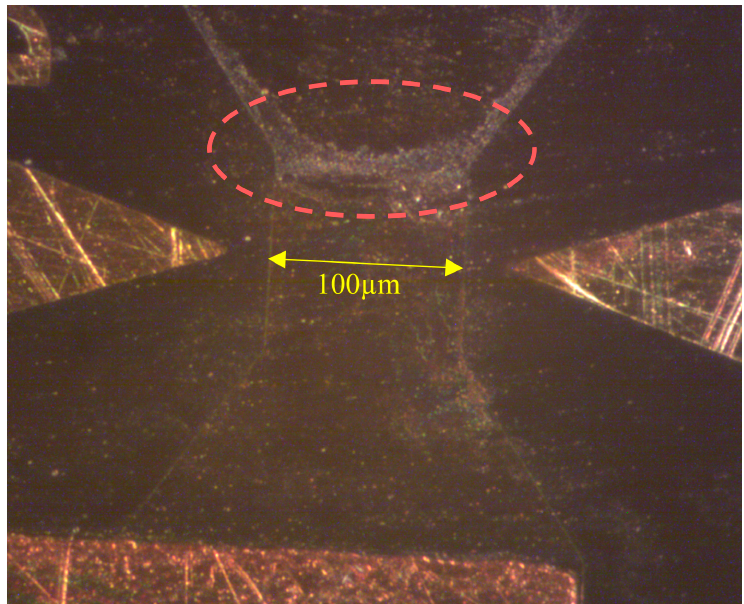
Figure 7. Trapezoid resistor burn out. Table 2. Experiment results sorted by lifetime achieved in comparison to the simulated normalized electric fields.